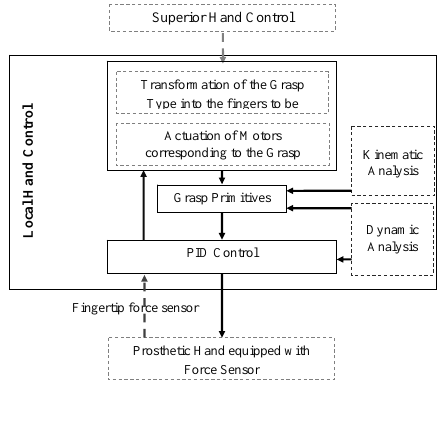
Figure 5. Schematic of Local Hand Control